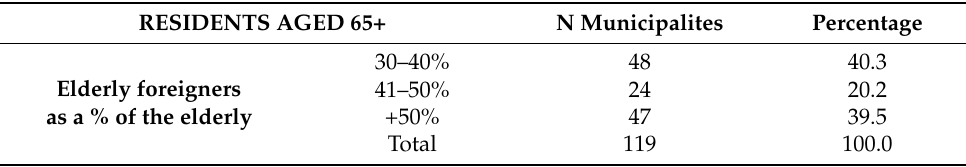
Table 1. Elderly foreigners as a share of the elderly